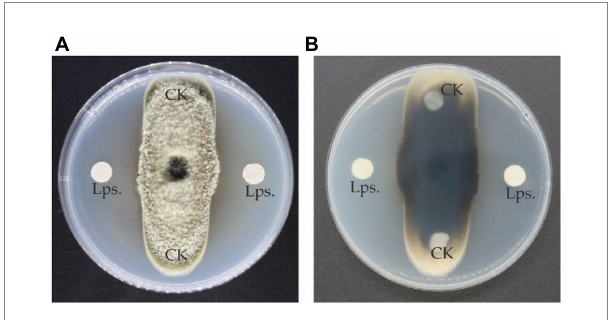
FIGURE 6 Antagonistic interaction of LPs with the pathogen. (A,B) Front (A) and reverse side (B) of the dual culture plate.